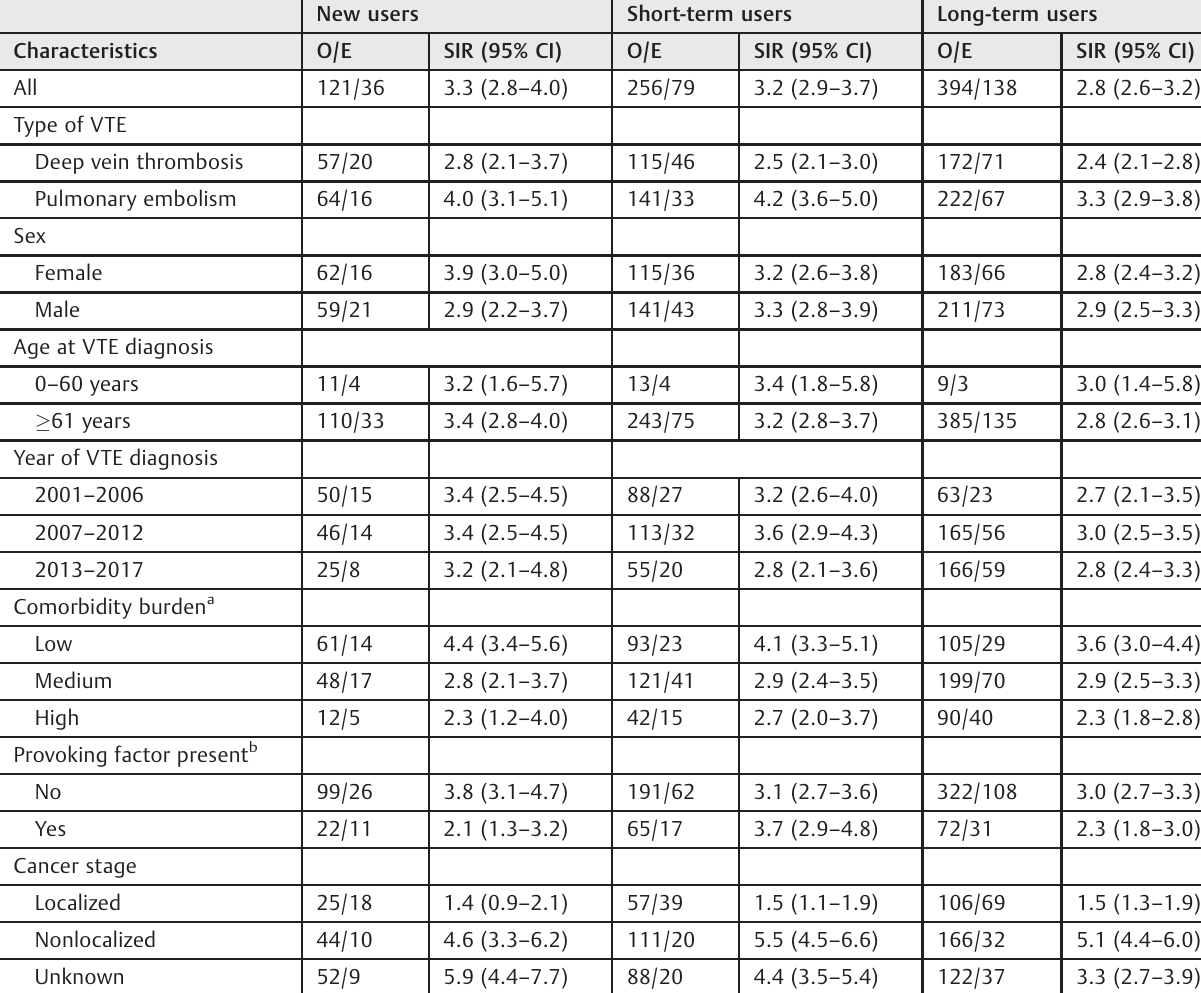
Table 3 Standardized incidence ratios for cancer in users of low-dose aspirin with venous thromboembolism during the fi rst year of follow-up